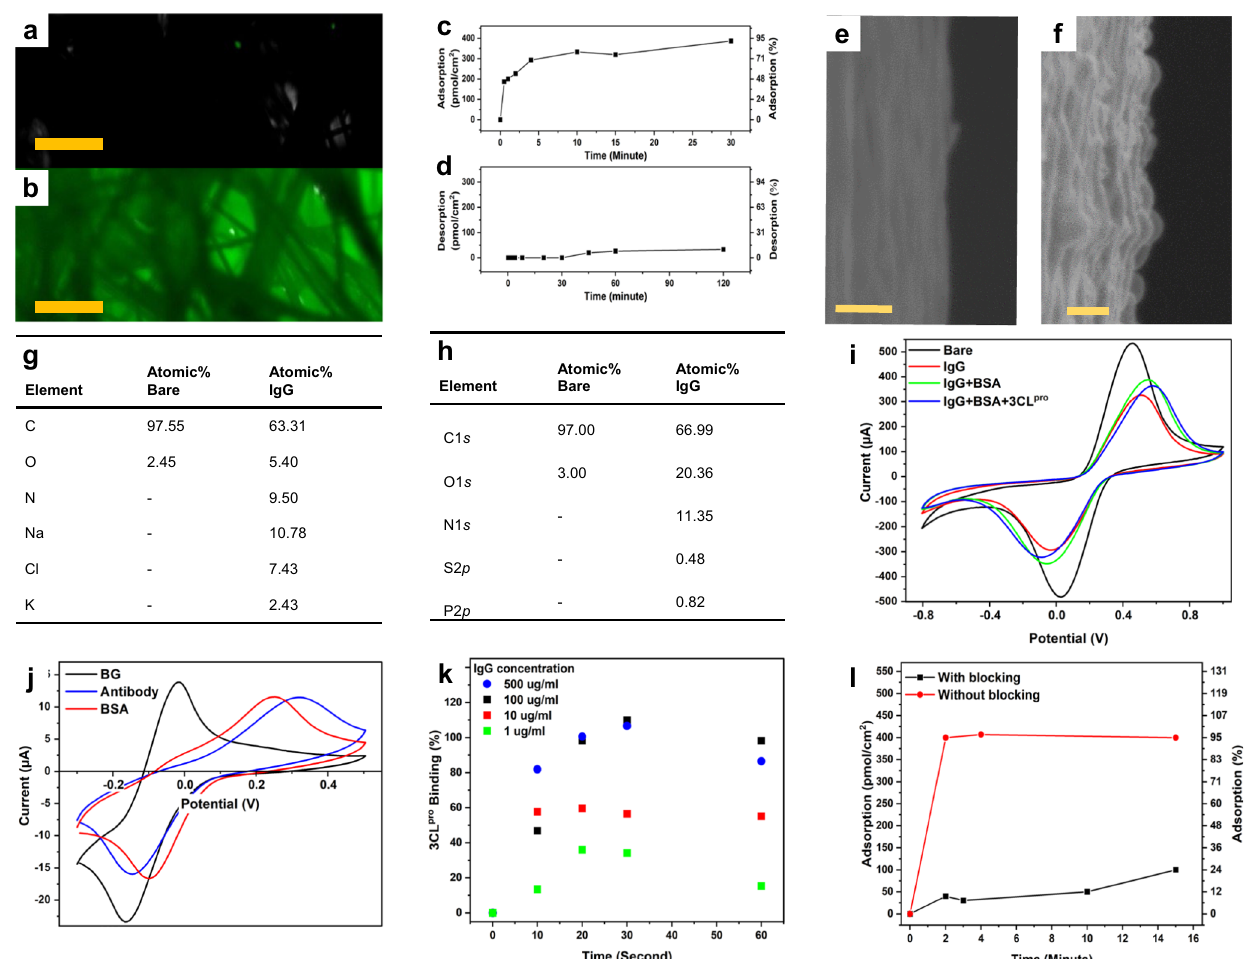
Fig.3| CPEimmuno-functionalization.a Fluorescencemicroscopyimageofbare CPE measured in PBS, scale bar: 1mm. b Fluorescence microscopy image of CPE treatedwith GFPmeasured inPBS, scalebar:1mm. c Antibody adsorptioncurve of 3CL pro -speci fi c antibody onto clean CPE. d Antibody desorption curve of 3CL pro antibody from 3CL pro antibody-treated CPE. e HR-SEM image of surfaces of bare CPE, scale bar: 100nm. f HR-SEM image of surfaces of CPE treated with 3CL pro antibody, scalebar: 100nm. g Atomic concentrations percentage results from EDS measurements before and after immuno-functionalization. h Atomic concentra- tions percentage results from XPS measurements before and after immuno- functionalization. i CVcurvesofimmuno-functionalizationsteps,Untreated(black)